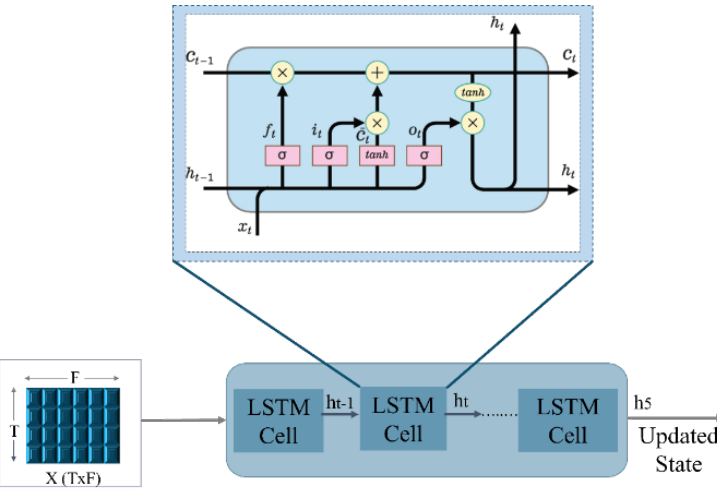
Figure 5. LSTM Cells Internal Structure.